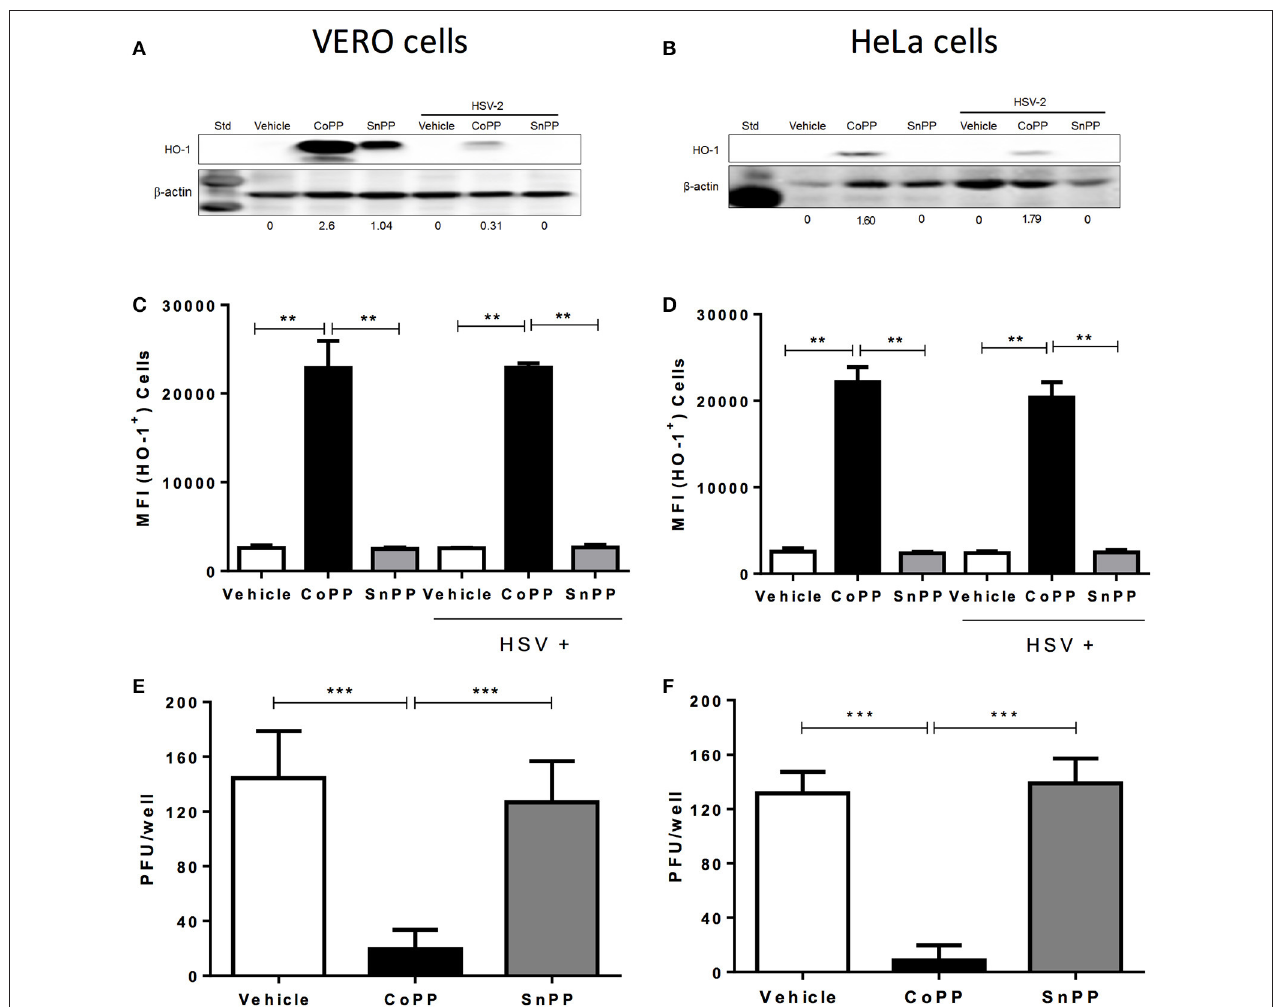
FIGURE 1 | HO-1 expression in epithelial cells treated with CoPP or SnPP and infected with HSV. (A,B) Western blot analyses of HO-1 expression in Vero (left) and HeLa cells (right) after treatment with HO-1-modulating drugs and/or infection with HSV-2 at an MOI 1 for 16h. (C,D) Flow cytometry analyses of HO-1 expression in Vero (left) and HeLa cells (right) after treatment with HO-1-modulating drugs and/or infection with HSV-2 at an MOI 1 (MFI, mean fluorescence intensity). (E,F) Virus plaque formation (PFU, plaque forming units) in Vero (left) and HeLa cells (right) treated with HO-1-modulating drugs and then infected with 150 PFU of HSV-2. Plaque forming units were determined at 18 and 36h post-infection for Vero and HeLa cells, respectively. Data are means ± SEM of three independent experiments. Representative images are shown for western blots. Two-way ANOVA, and Tukey’s multiple comparison test were used for statistical analyses (** p < 0.01, *** p <